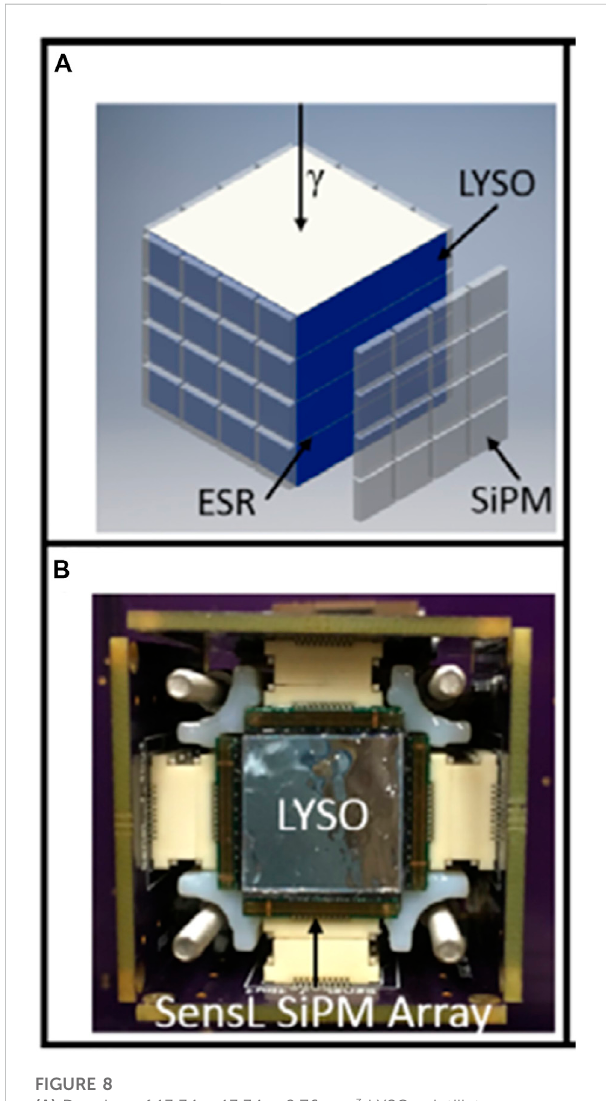
FIGURE 8 (A) Drawing of 13.34 × 13.34 × 2.76 mm 3 LYSO scintillators layered in a stack of four with side readouts using four 4 × 4 arrays of SiPMs on each side face of the scintillators. The scintillators are separated by enhanced specular re fl ector (ESR) fi lms between each crystal. (B) Image of the system from the top with SensL SiPM arrays coupled to the side of the LYSO scintillator. Reproduced with permission from [122] Ⓒ Institute of Physics and Engineering in Medicine. Reproduced by permission of IOP Publishing Ltd. All rights